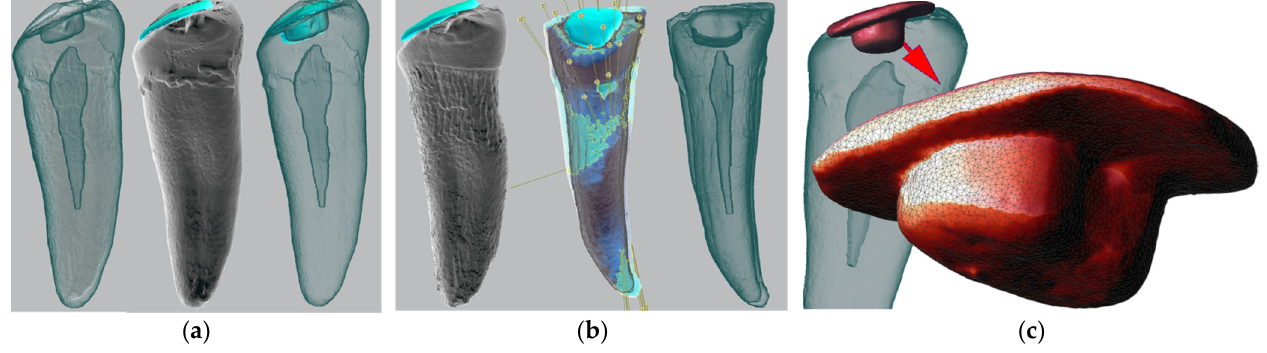
Figure 7. Outputs from micro-CT segmentation: ( a ) Original segment of tooth 34 before acid bath; ( b ) segments of tooth and dental filling after 96 h in acid bath; ( c ) 3D-reconstructed dental filling for future projections over various 2D (typically) diagnostic pre-mortem dental records (X-rays, digital intraoral photography).